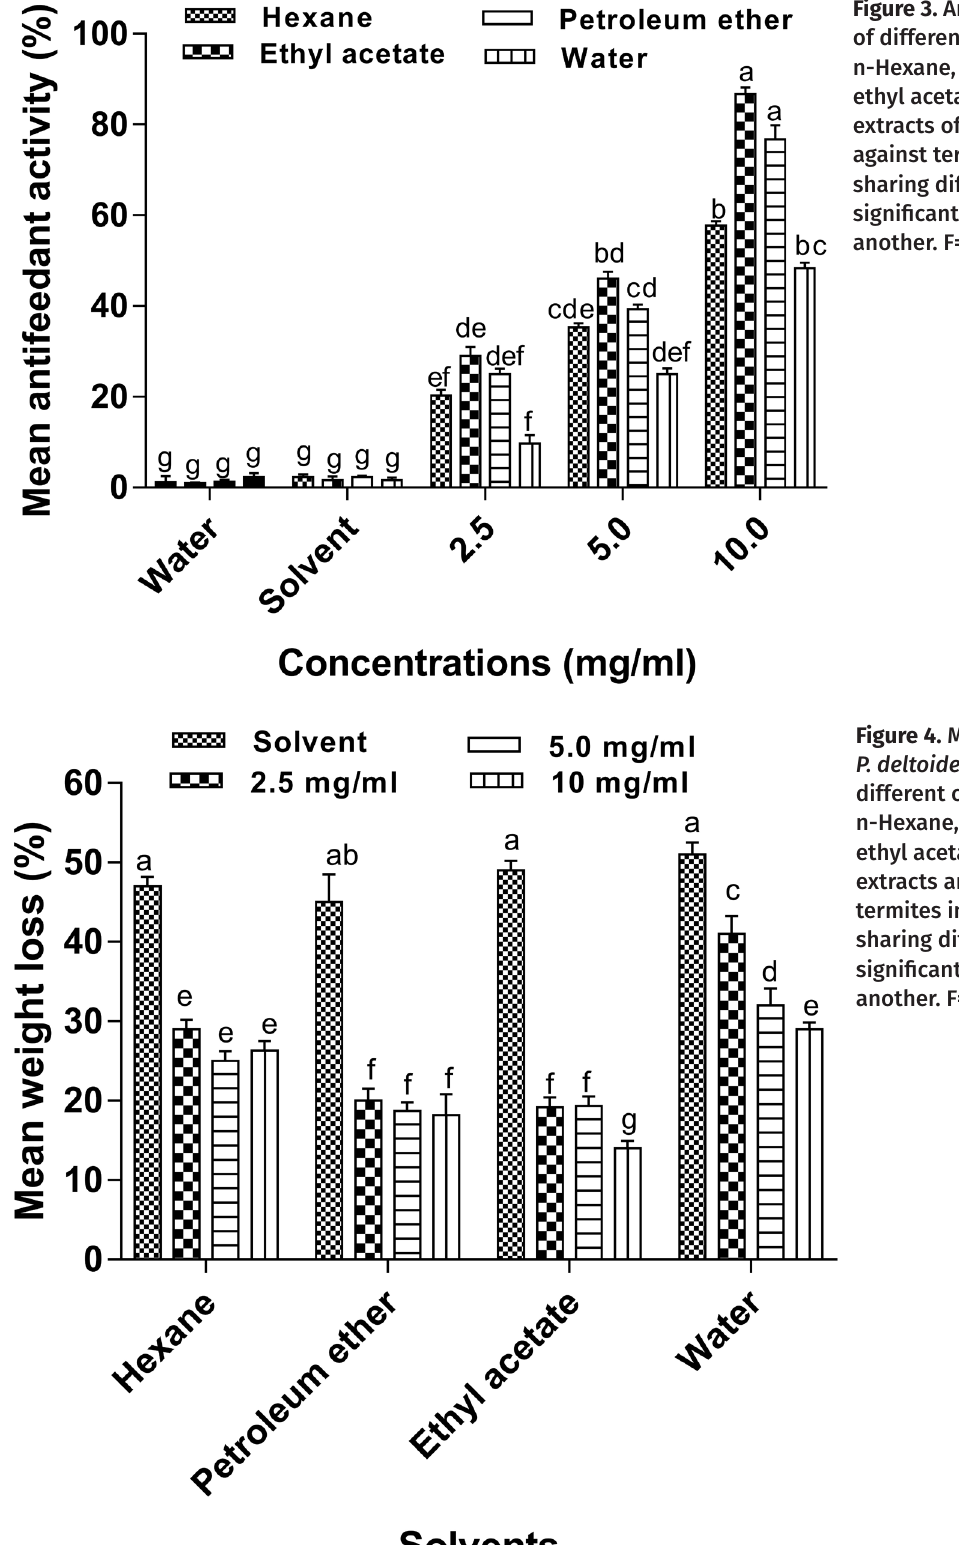
Figure 3. Antifeedant activities of different concentrations of n-Hexane, petroleum ether, ethyl acetate, and water extracts of P. pinnata wood against termites. Means sharing different letters are significantly different from one another. F=3.03,